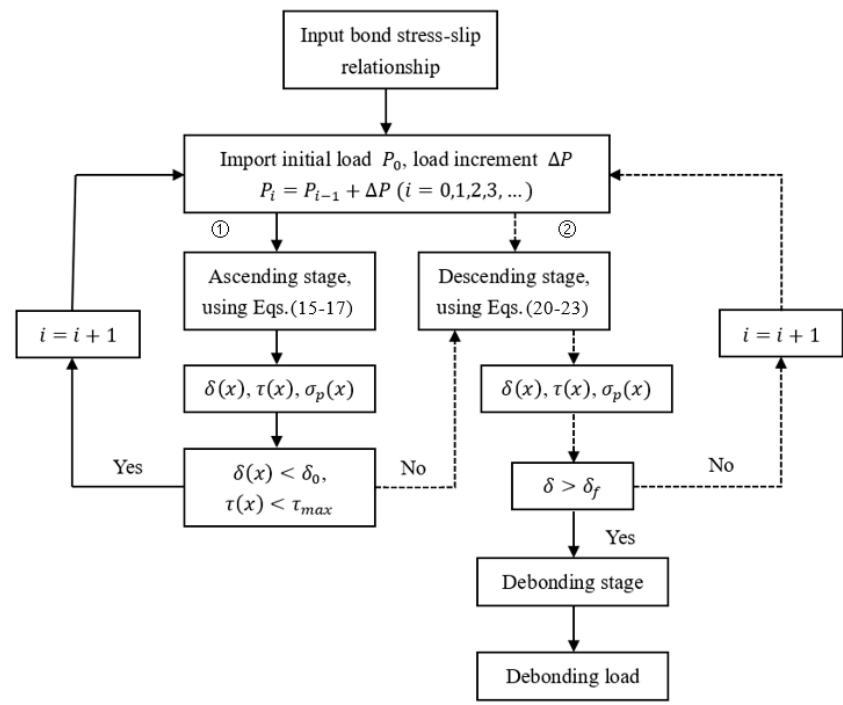
Figure 14. Flow chart for analytical solution.